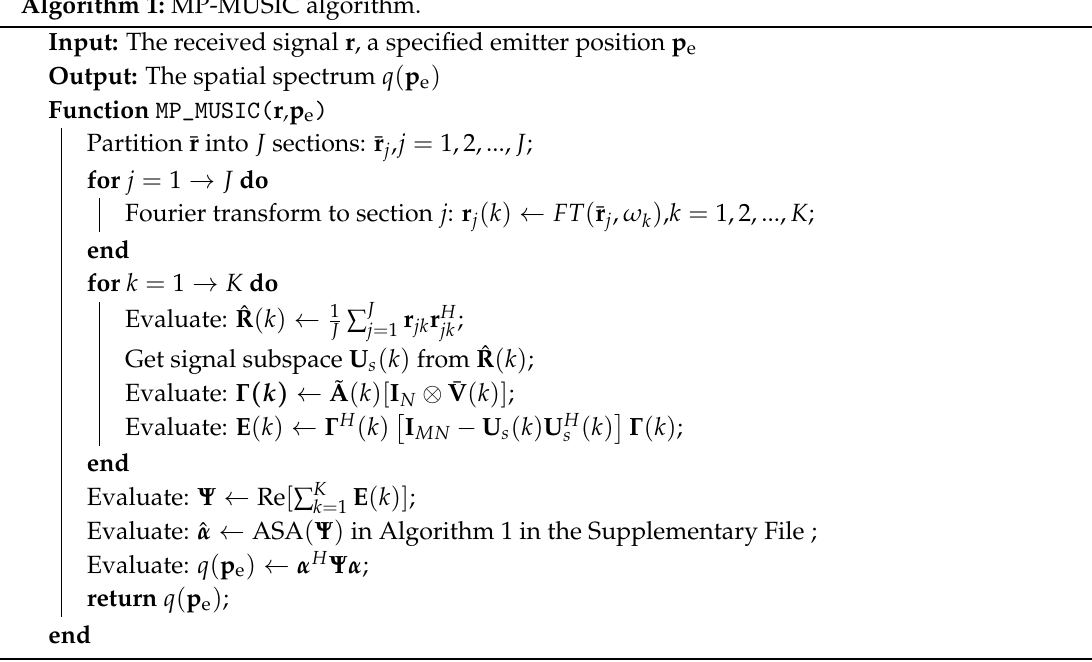
Algorithm 1: MP-MUSIC